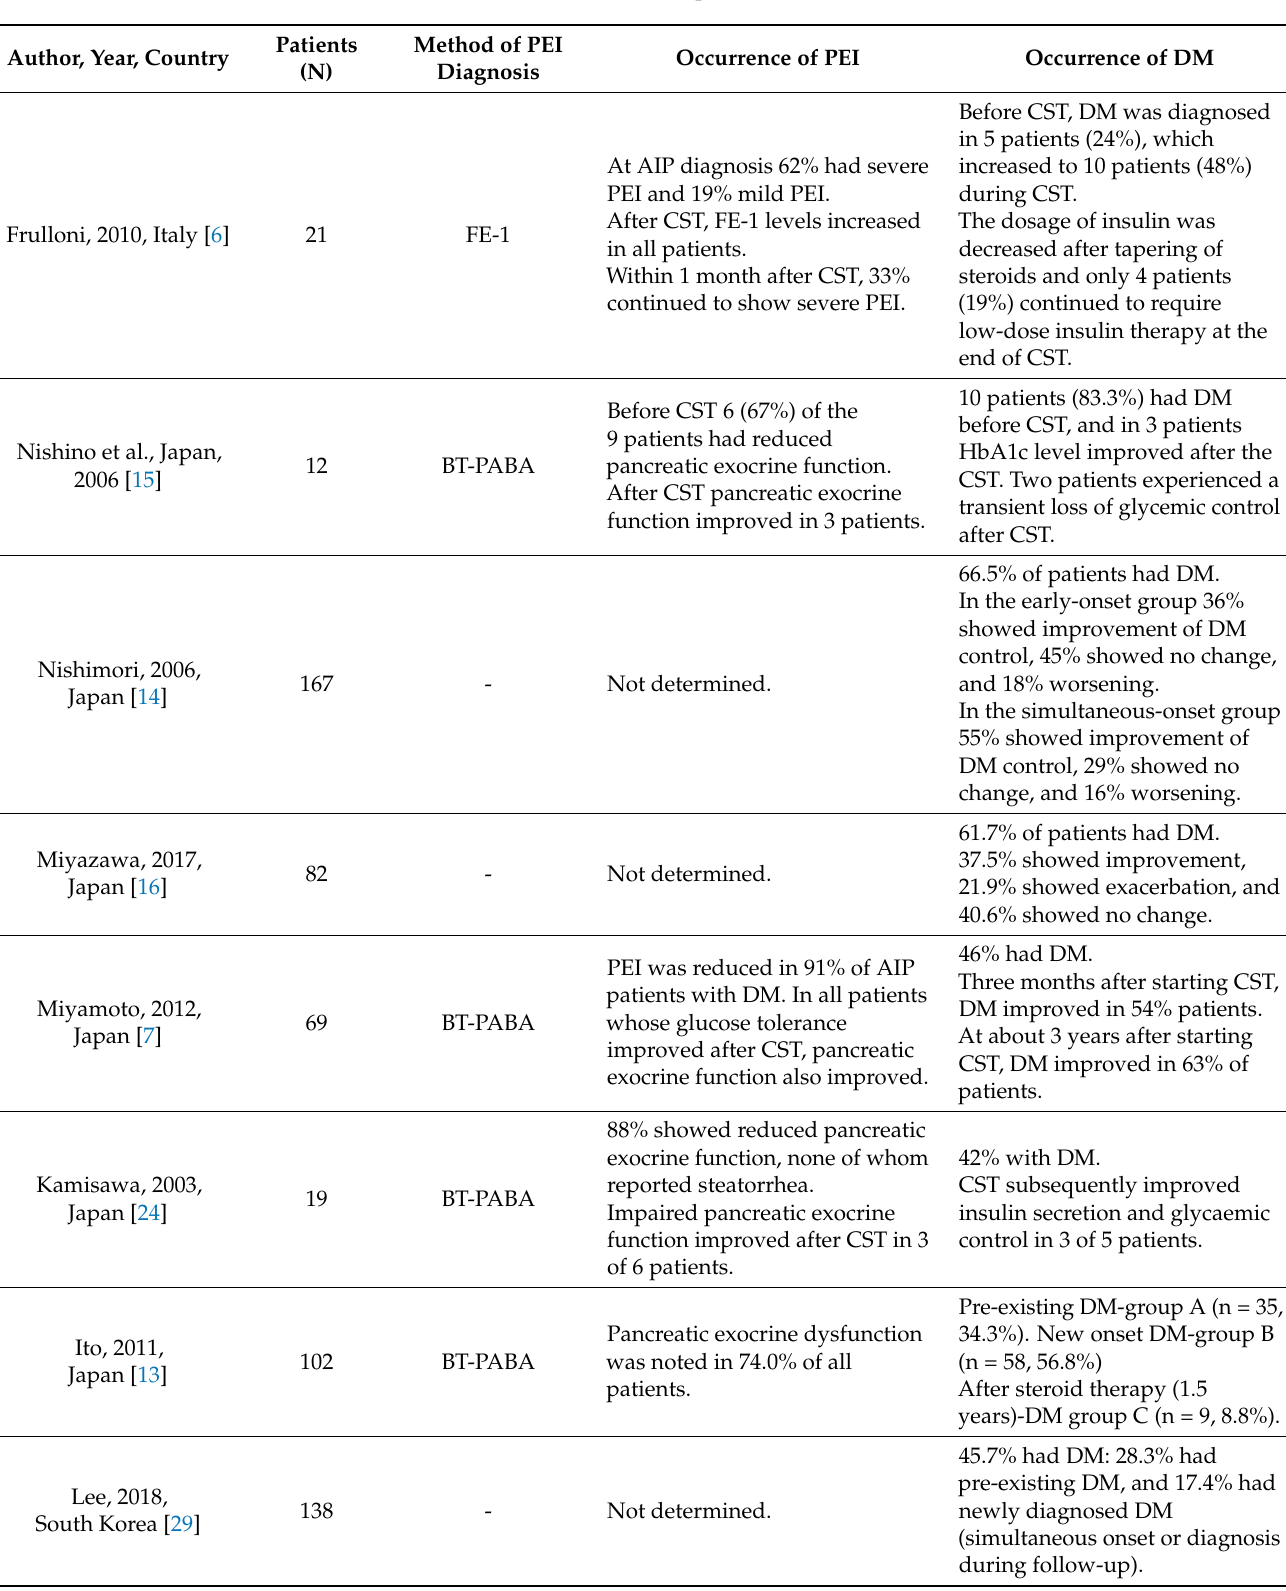
Table 3. Occurrence of PEI and DM in patients with AIP in different